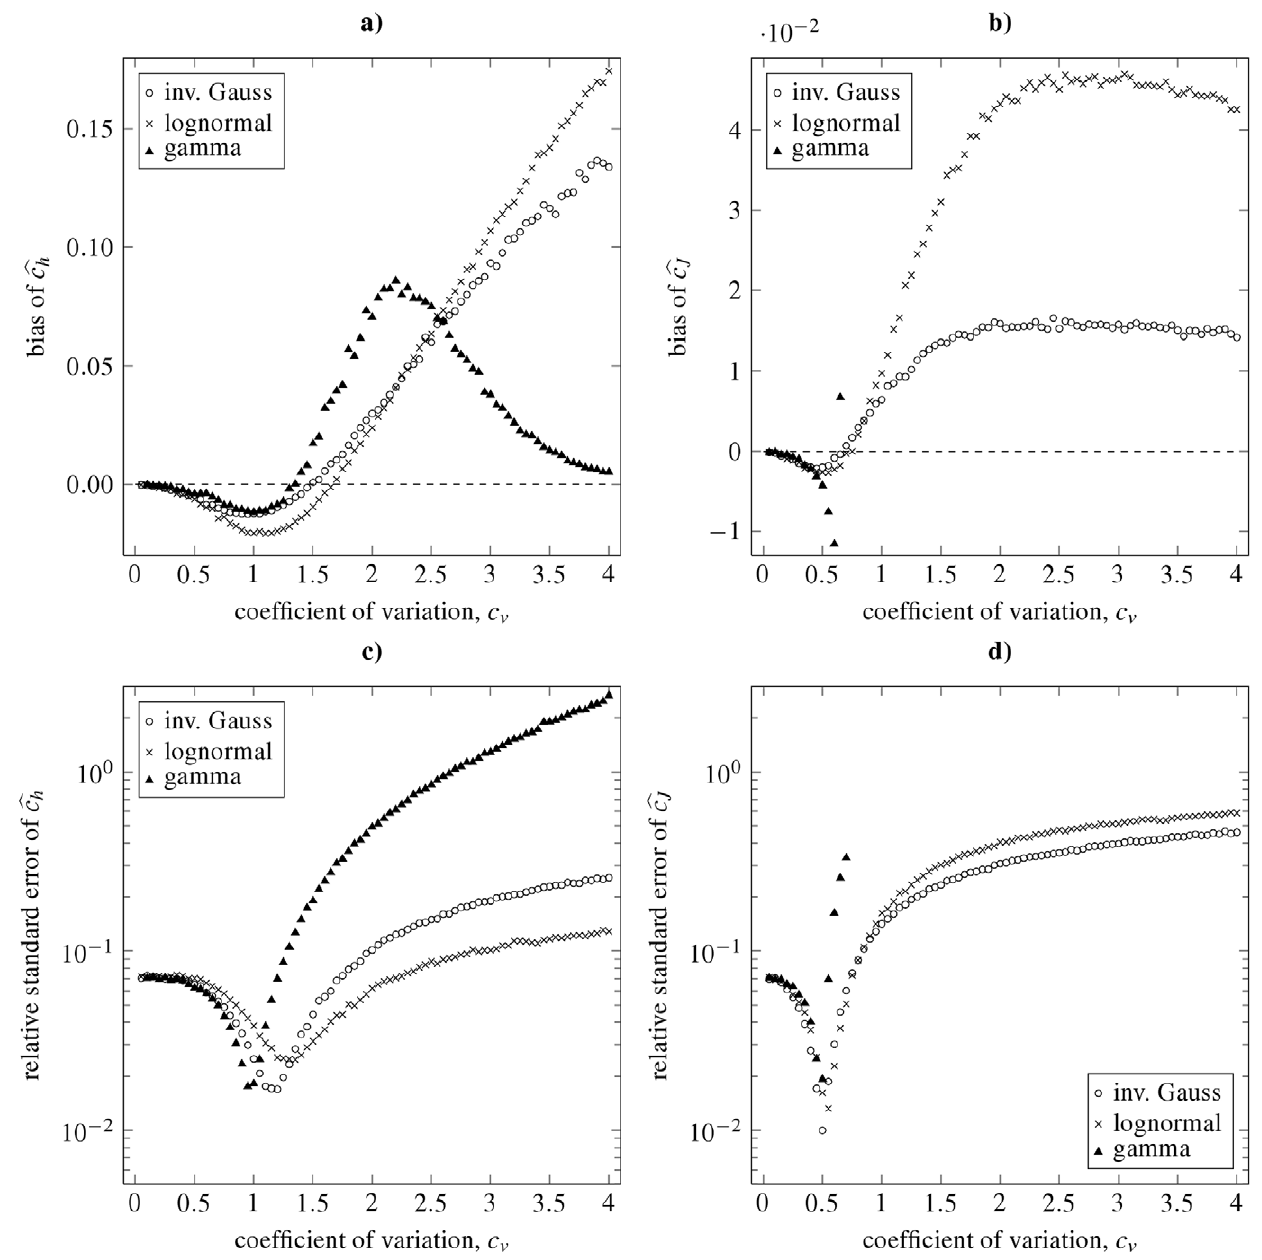
Figure 8. Dispersion coefficients estimation by using the moment method. The structure of the panels and the notation are equivalent to those in Fig. 7, except that the estimates b c v c v , and consequently b c h c h and b c J c J were estimated by the moment method.